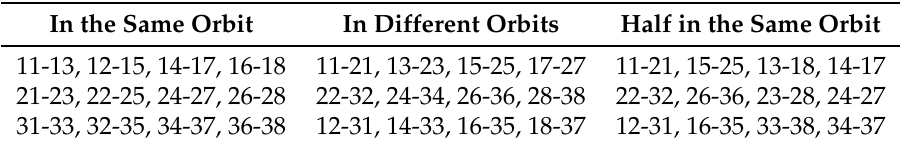
Table 2. Link plans used in the numerical